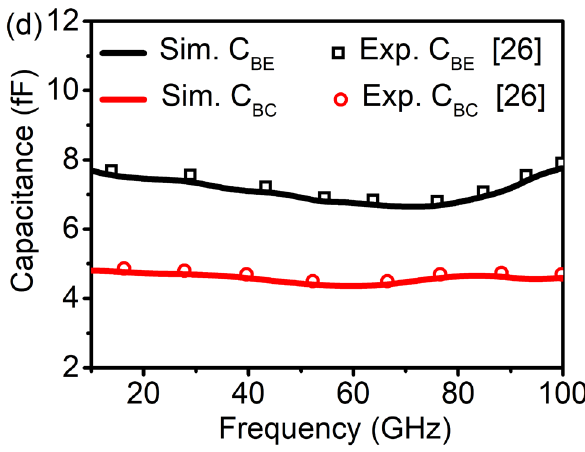
Figure 3. Calibration: ( a ) Phu − Mob model with experimental data [24]; ( b ) forward Gummel characteristics with experimental data [25]; ( c ) f T and f max at V CB = 0.5 V with experimental data [4]; ( d ) emitter-base ( C BE ) and collector − base ( C BC ) junction capacitances with measurement data [26]. Table 2. Numerical Device Simulation Parameters.